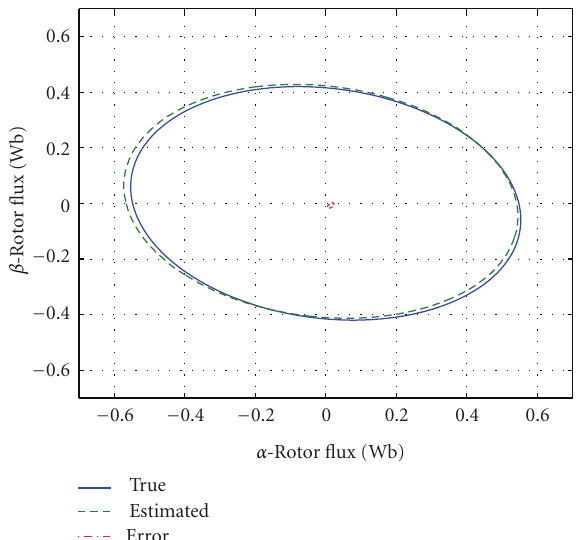
Figure 9: Phase portrait λ rα × λ rβ of rotor flux for 50 Hz considering the loaded SPIM (computational simulation).